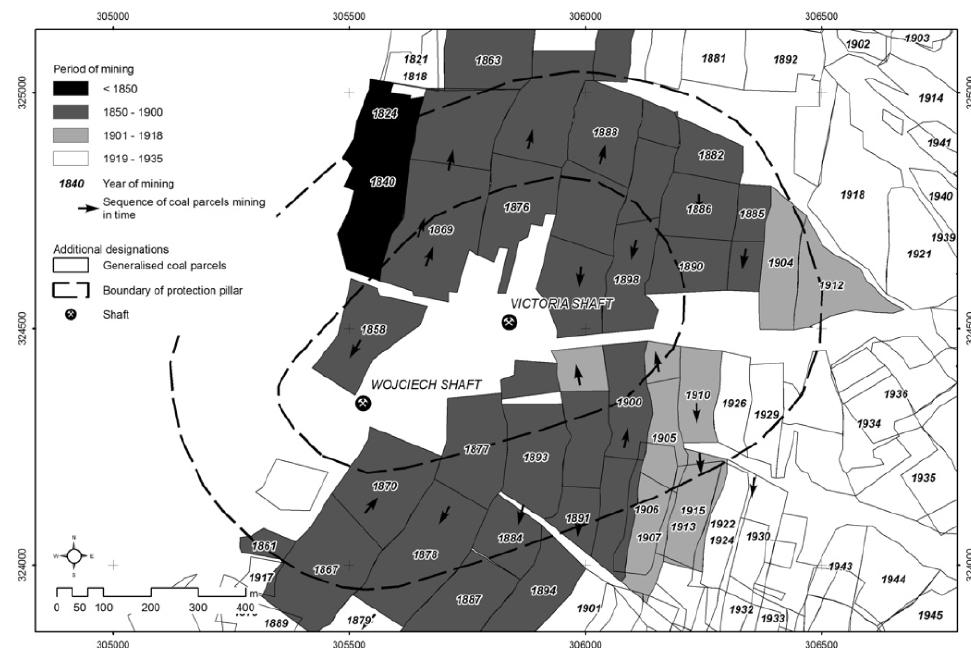
Figure 10. Mining activity analysis for the 424/425 coal production level within the boundaries of the protection pillar.